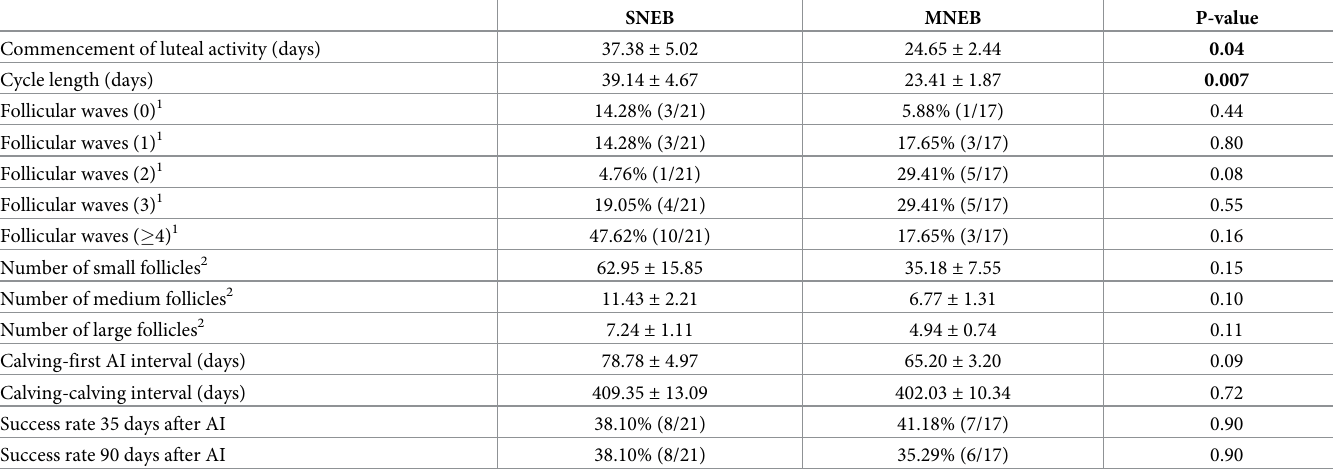
Table 2. Reproductive parameters of cows either with severe (SNEB) or with moderate (MNEB) negative energy